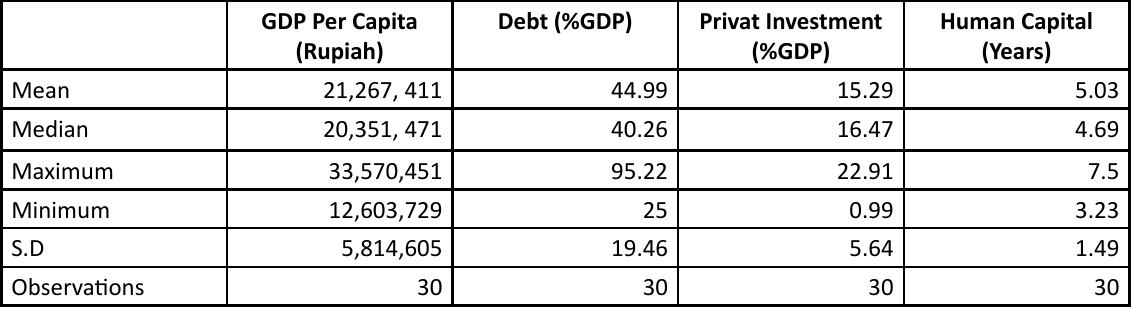
Table 1B: Descriptive Statistics - Growth Model Variables- Indonesia